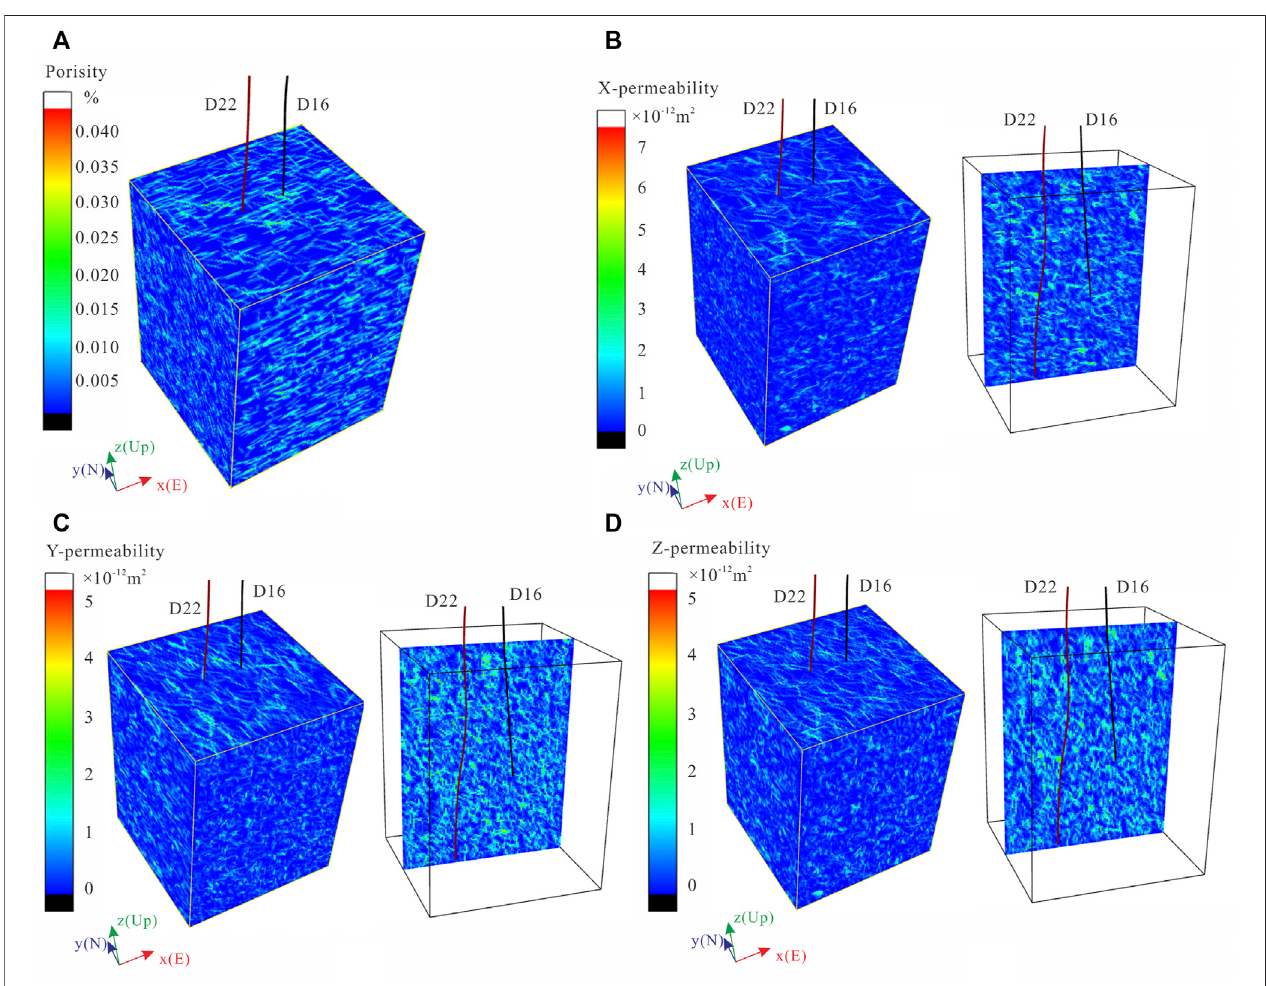
FIGURE 8 | (A) Calculated porosity and permeability (B – D) in the reservoir grid. Earch of the permeability map contains a slice through D22 and D16.